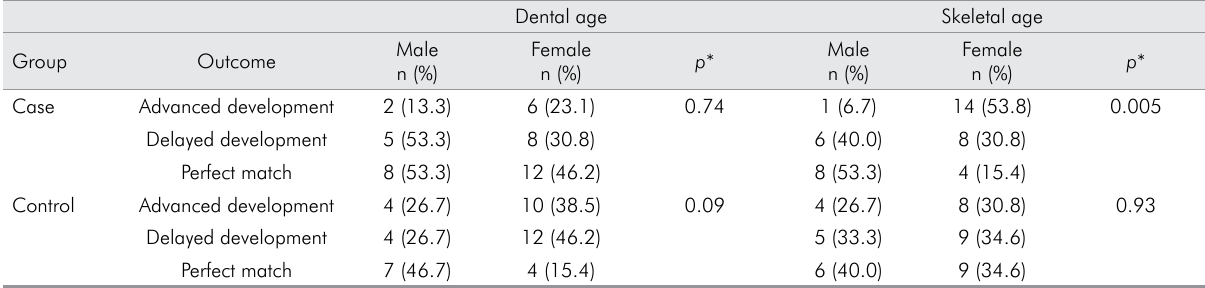
Table 2. Distribution of dental and skeletal ages among male and female patients in the case and control groups in relation to chronological